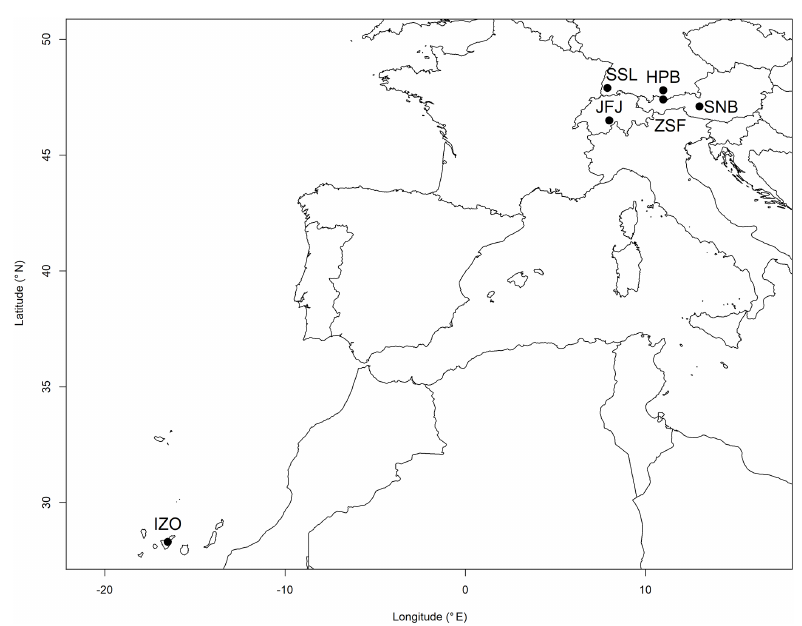
Figure 1. Locations of six European elevated mountain stations. Symbols from left to right stand for: IZO – Izaña, Spain; SSL – Schauinsland, Germany; JFJ – Jungfraujoch, Switzerland; HPB – Hohenpeissenberg, Germany; ZSF – Schneefernerhaus-Zugspitze, Germany; SNB – Sonnblick, Austria. Table 1. Information of measured CO 2 datasets at six GAW mountain stations. Station (GAW ID) Sampling elevation (a.s.l.) Time period (yyyy.mm) Data